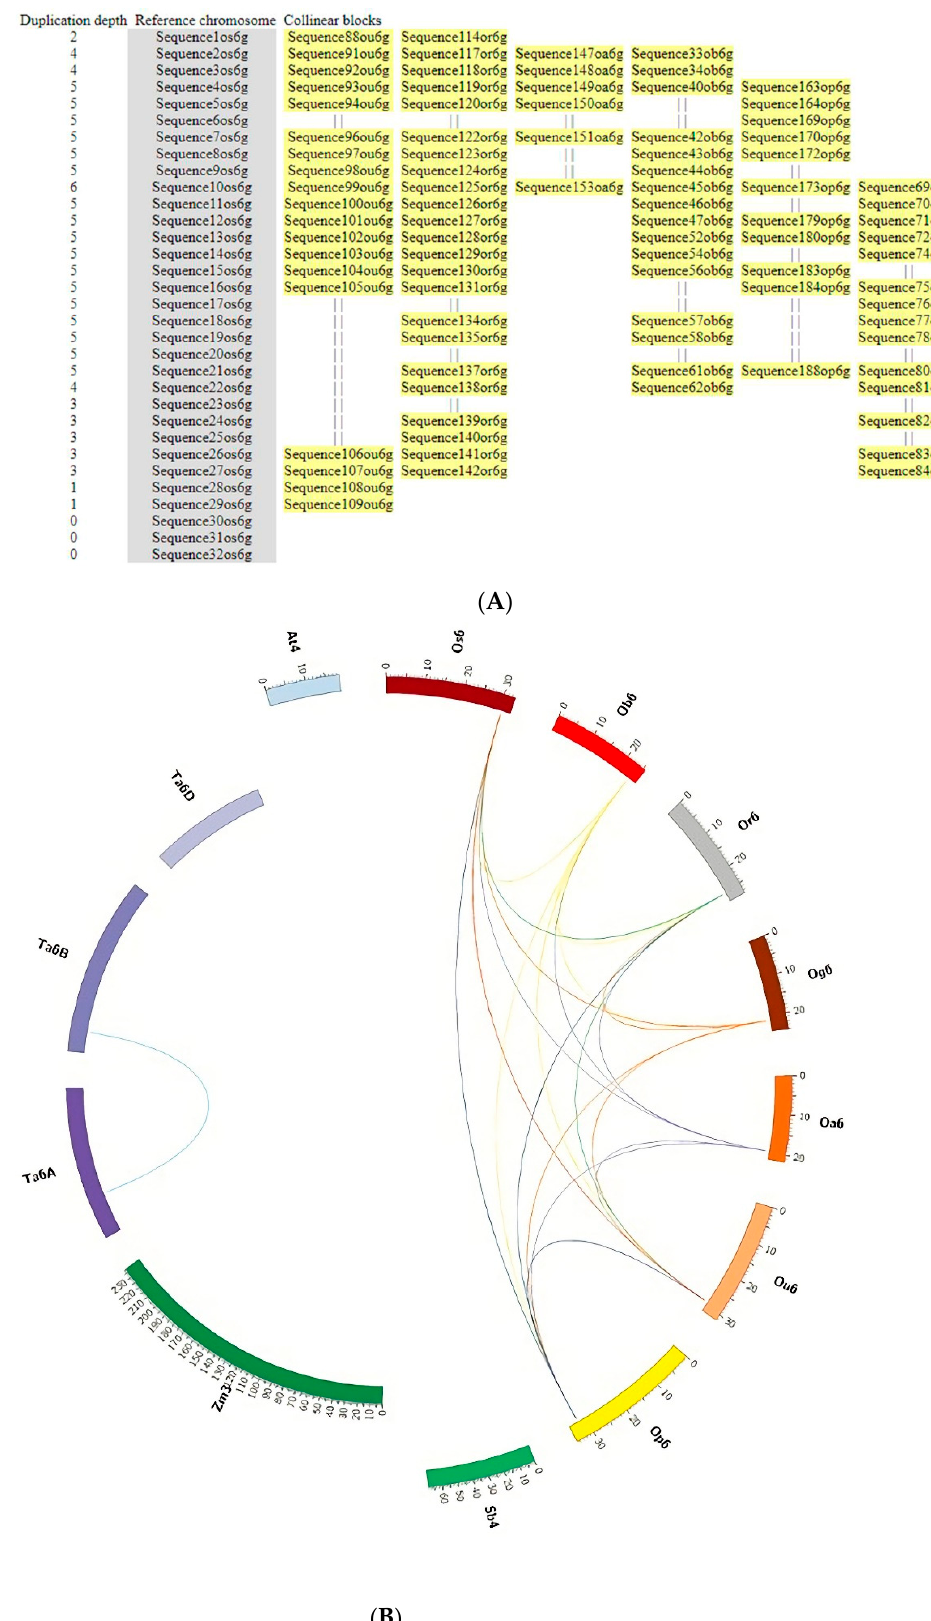
Figure 5. Diagrammatic representation of microsynteny analysis of 100 kb genomic segments flanking MIR397A across different poaceae members. ( A ) Synteny block diagram for MIR397A with O. sativa as reference. The first column shows duplication depth at each gene locus; the second column shows the genes in reference chromosomes, and the following one show aligned collinear blocks where only match genes are displayed. The alignment among non-anchor genes was discarded in the output and was simply denoted with “||” in the multi-alignment of gene orders. ( B ) Circular plot showing patterns of synteny and collinearity. Os6— O. sativa chr 6; Ob6— O. barthii chr 6; Og6—